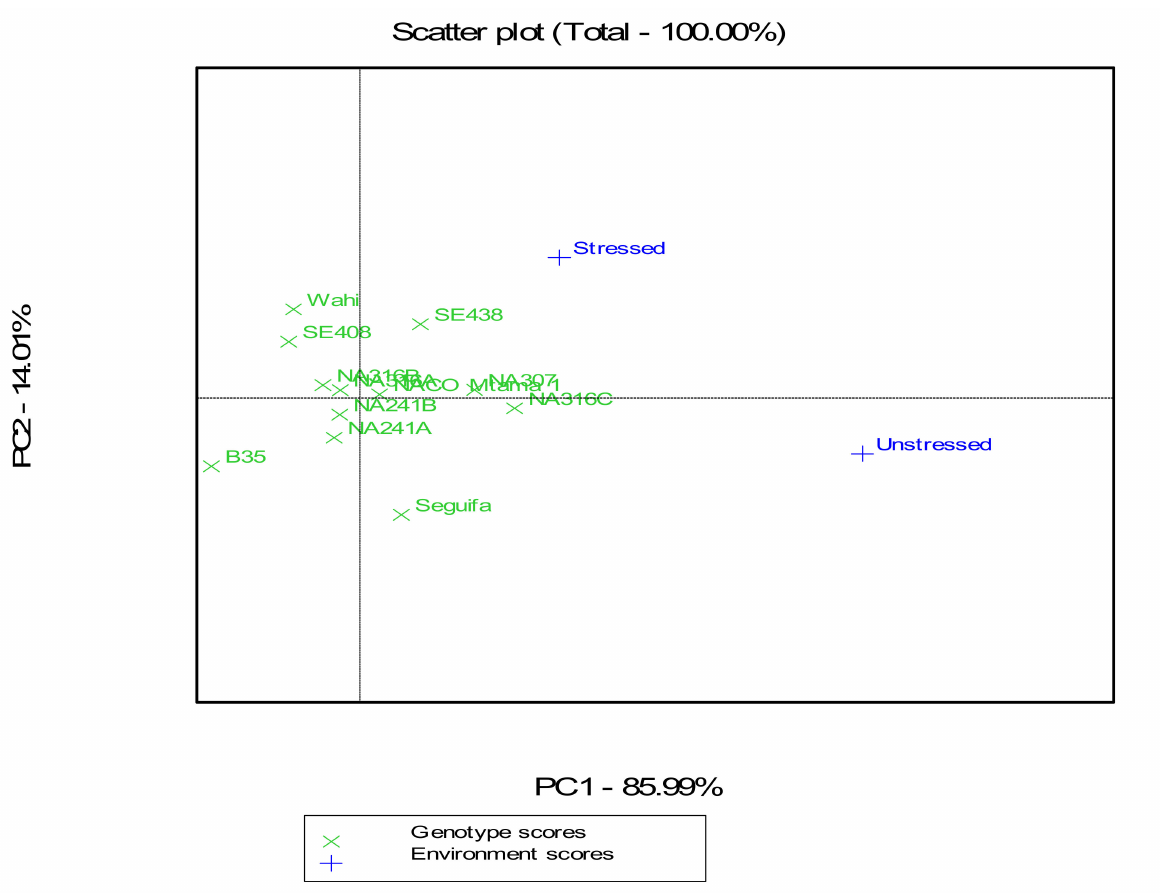
Figure 1. PCA of grain yield under water-stressed and well-watered